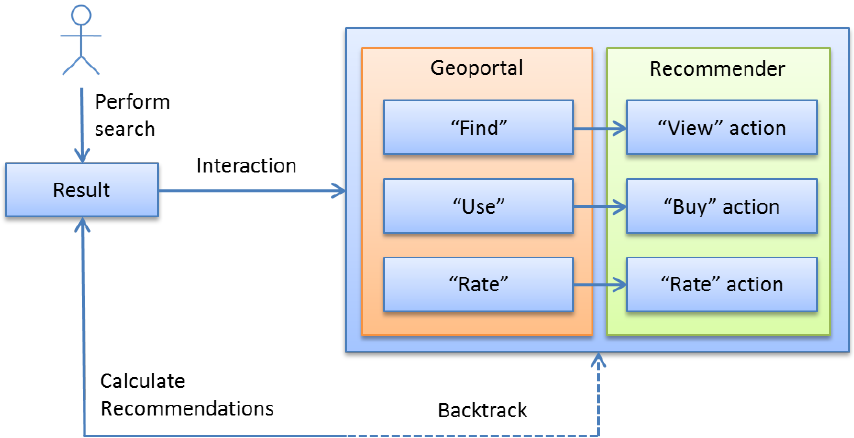
Figure 3. User interaction recommendation